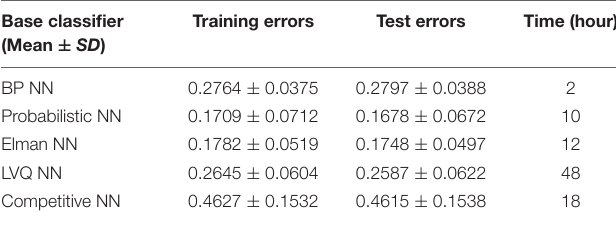
TABLE 2 | The errors and running time of five types of random neural network